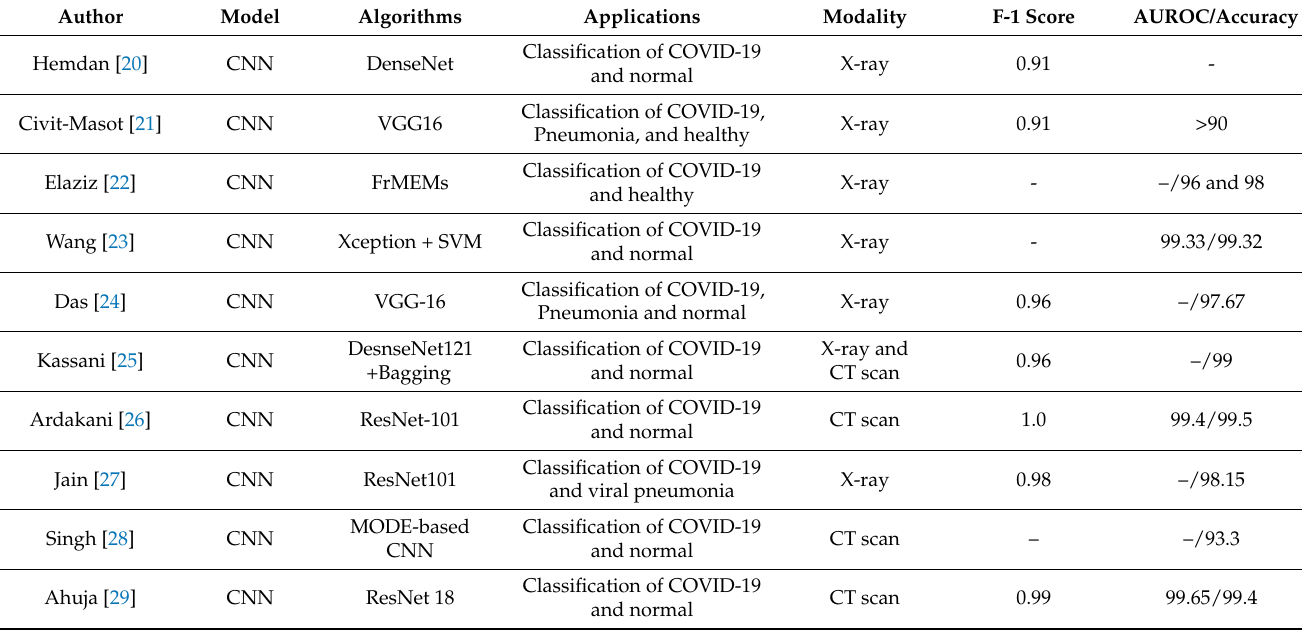
Table 1. The performance of AI model for COVID-19